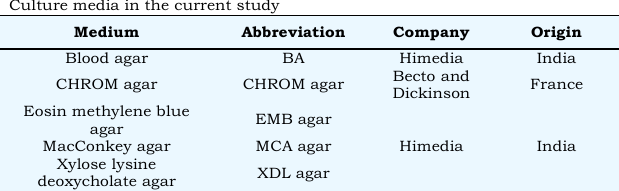
Table 2 Culture media in the current